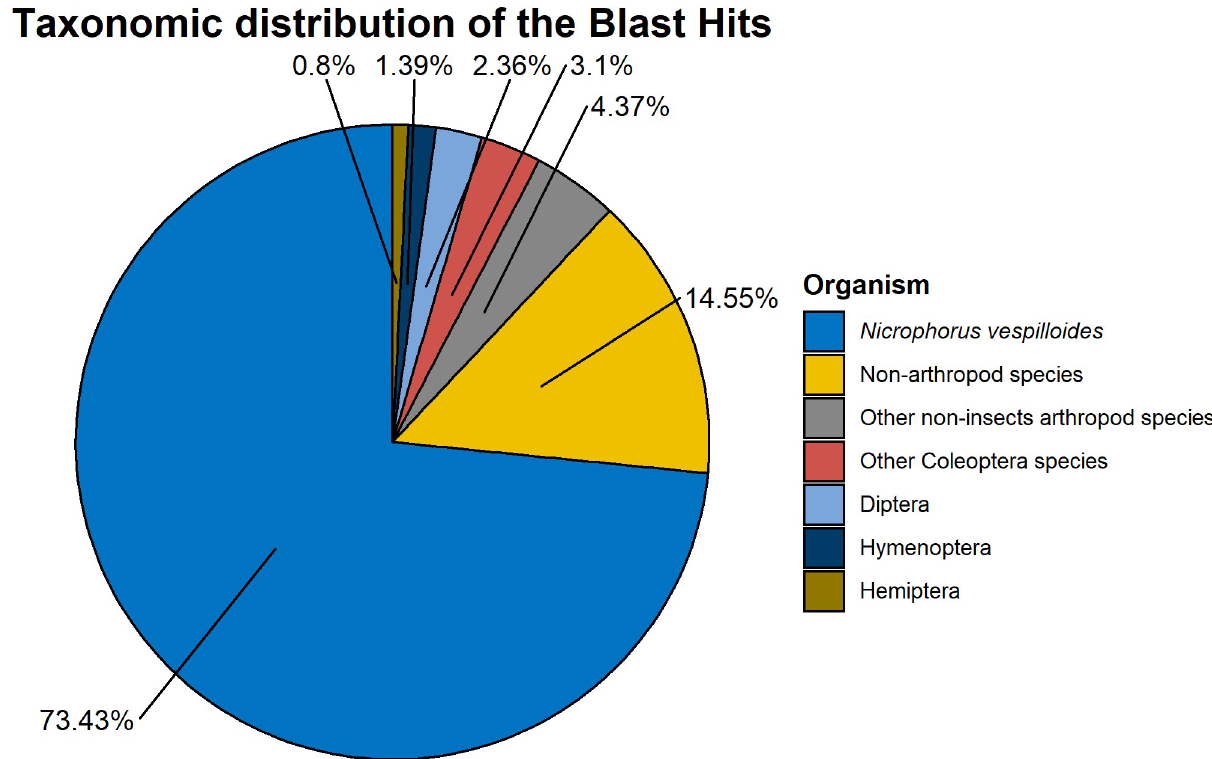
Fig 2. Taxonomic distribution of the Blast hits of the unigene